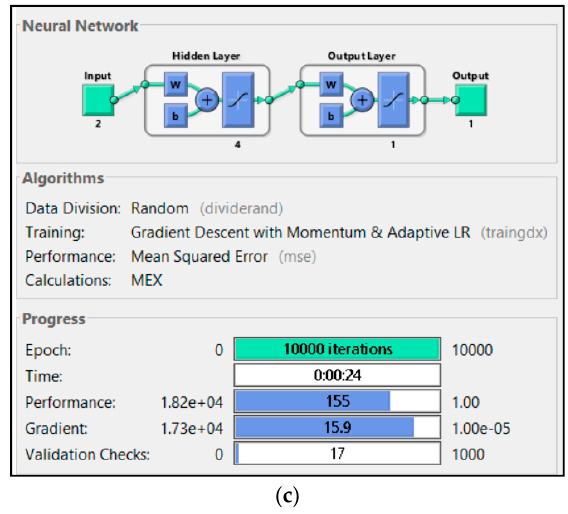
Figure 9. Training results of ( a ) P1 + P2, ( b ) P1 + P3 and ( c ) P2 + P3.